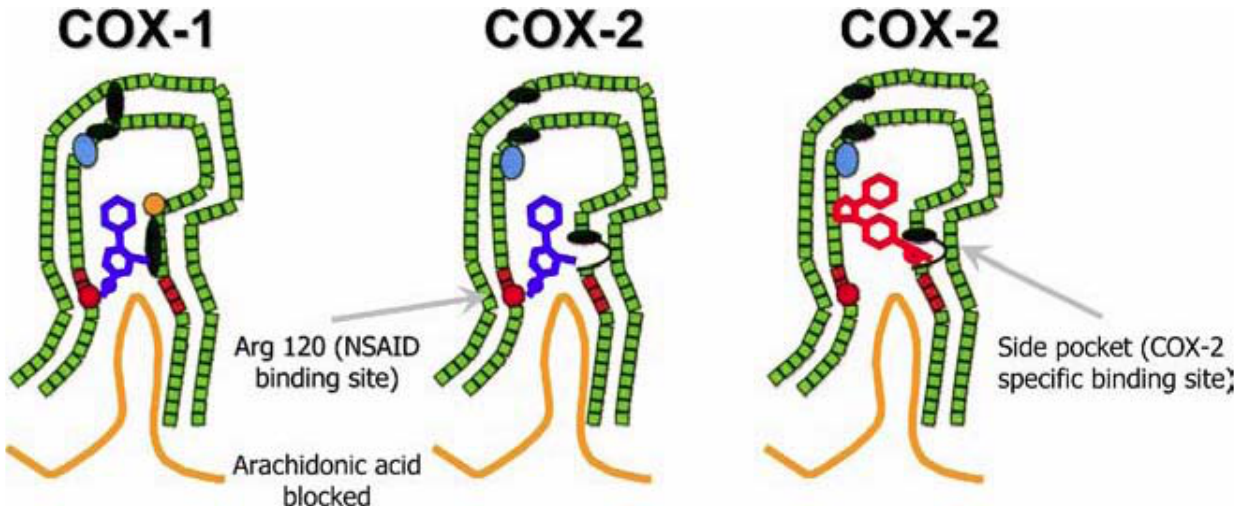
Figure 1. Left: schematic representation of the inhibition of COX-1 (large green figure) by a nonselective NSAID (central blue figure). The entrance channel to COX-1 is blocked by the NSAID. Binding and transformation of arachidonic acid (bottom yellow figure) within COX-1 is prevented. Middle: inhibition of COX-2 by a nonselective NSAID (central blue figure). Right: inhibition of COX-2 by COX-2 selective NSAID (central red figure). The COX-2 side pocket allows specific binding of the COX-2 selective NSAID’s rigid side extension. The entrance channel to COX-2 is blocked. The bulkier COX-2-selective NSAID will not fit into the narrower COX-1 entrance channel, allowing uninhibited access of arachidonic acid into COX-1. Adapted from Hawkey CJ